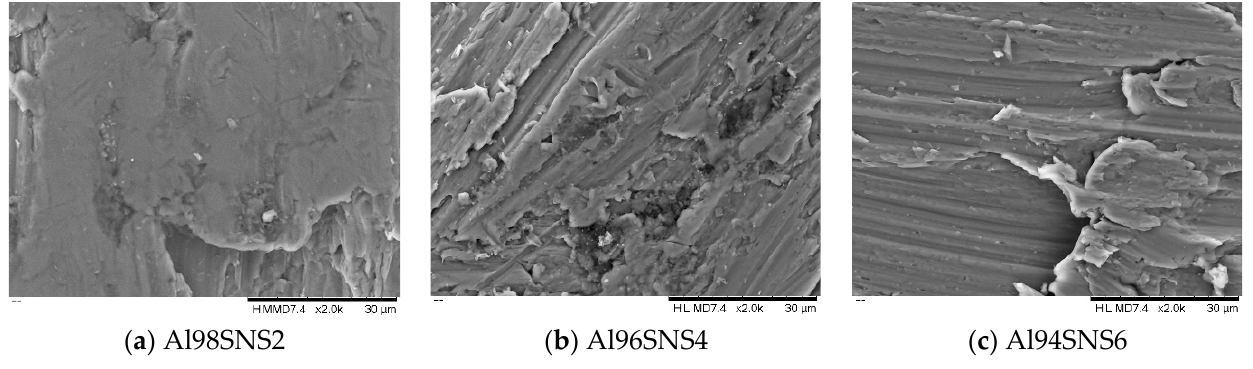
Figure 3. SEM images of the investigated samples. Table 5. Roughness results of the as received surface (before corrosion or tribological tests) (averaged values of 10 profiles on each investigated sample).